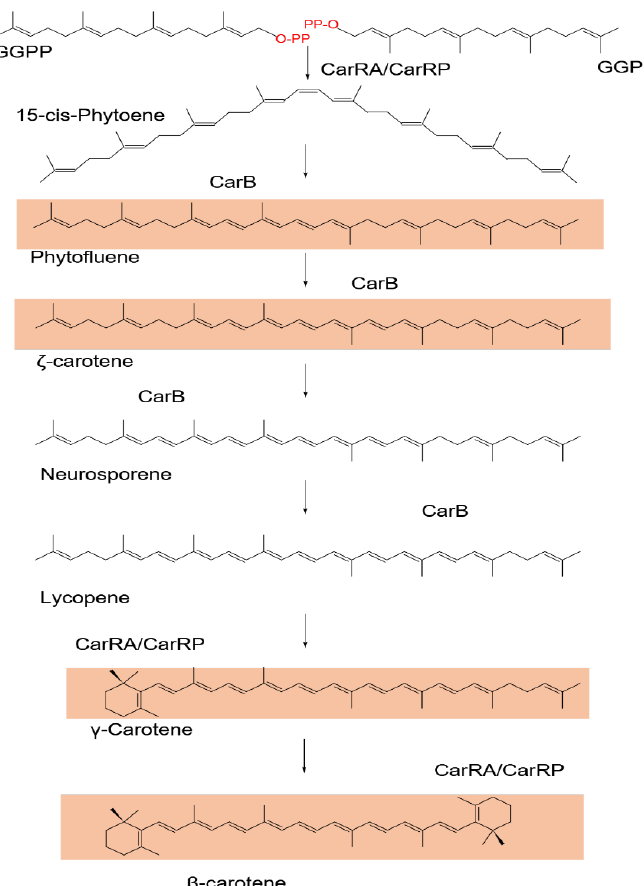
Figure 2. Biosynthetic pathway of carotenoid (from GGPP) from fungi. The figure has been repro- duced following Avalos [120,121].